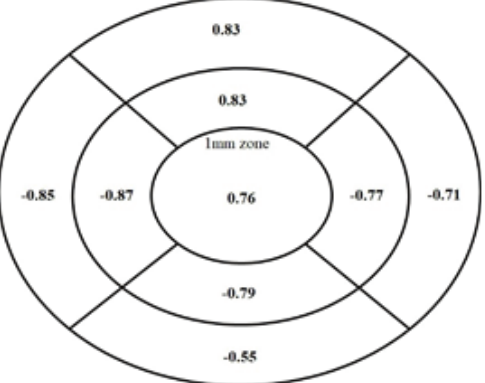
Figure 4. Pearson correlation coefficients (r) between refractive errors and retinal thicknesses (µm) at nine retinal locations using the Early Treatment Diabetic Retinopathy Study (ETDRS)